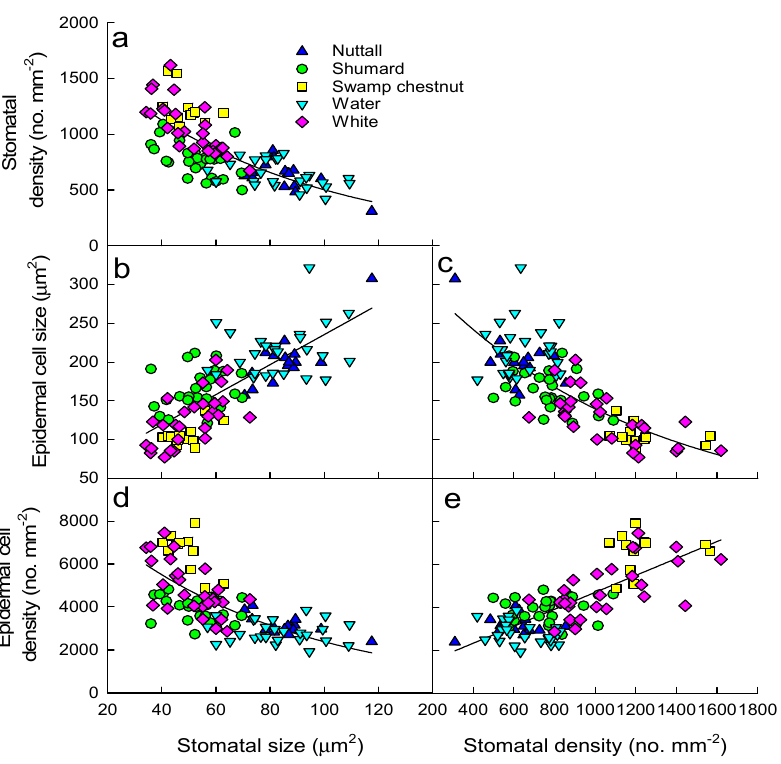
Figure 5. Regressions of leaf epidermal properties including ( a ) stomatal density (no. mm − 2 ) vs.